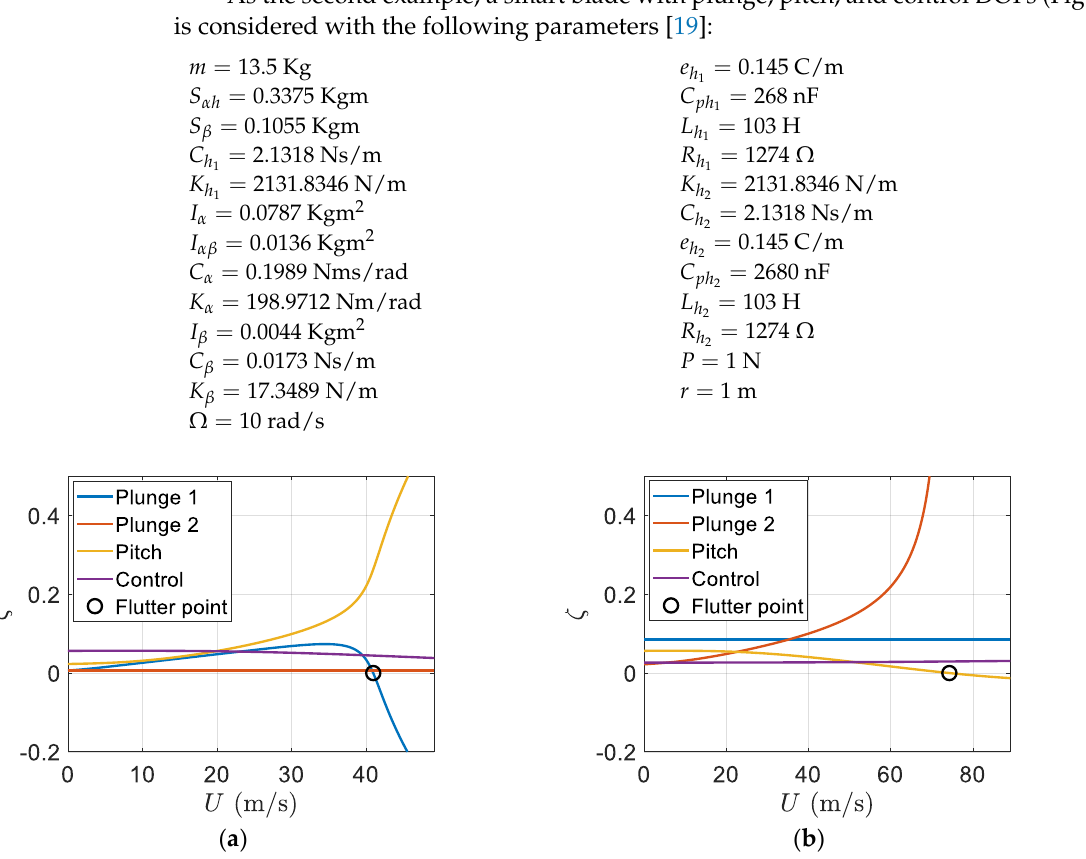
Figure 10. Damping ratio versus airspeed: ( a ) regular blade; ( b ) smart blade.